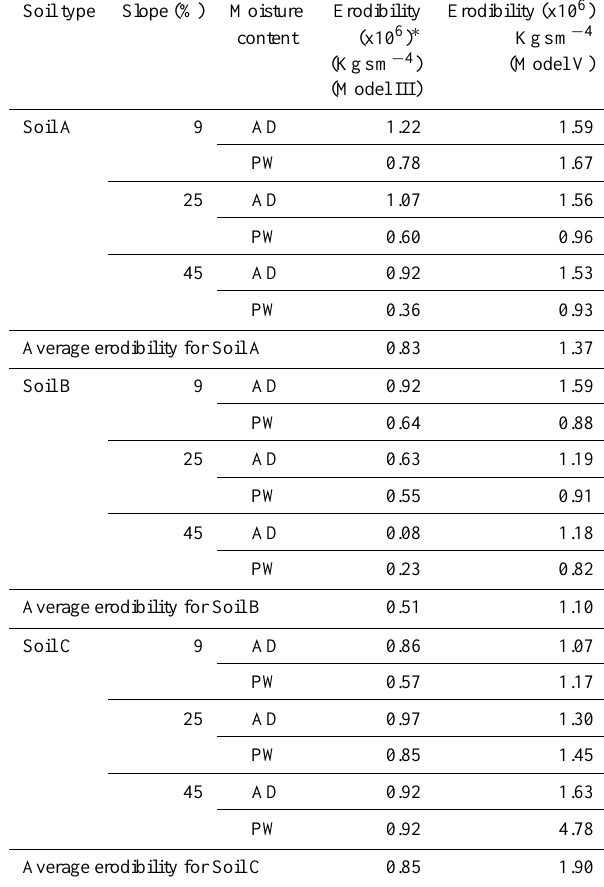
Table 10. Soil erodibility values for the three soils at different slope and initial moisture content